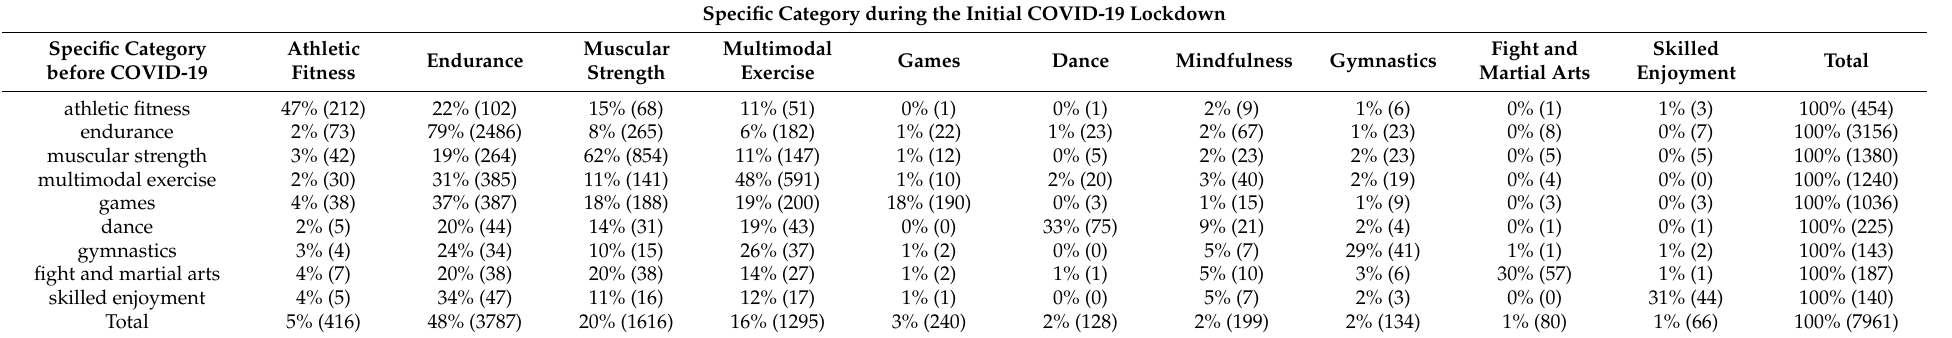
Table A4. Change in the specific category including exact numbers and percentages of continuous